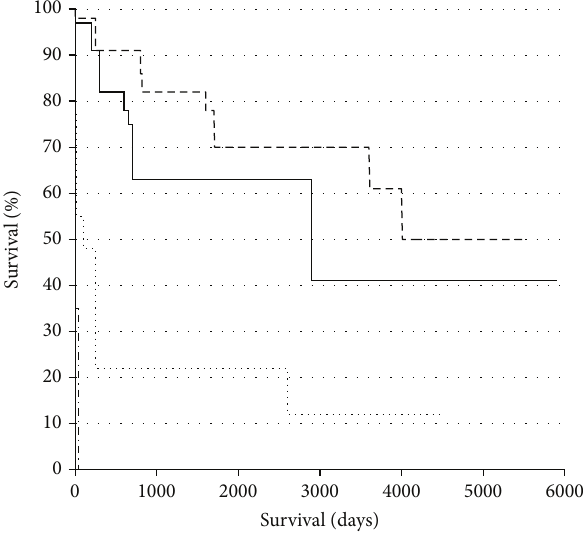
Figure 1: Km survival curves were plotted for patients grouped according to comorbidity score (dashed line: comorbidity 0 + 1; continuous line: comorbidity 2 + 3; dotted line: comorbidity 4 + 5; and dashed/dotted line: comorbidity > 6). Logrank test for trend indicated a significant increase in rate of death with comorbidity score, and compared with comorbidity 0 + 1, the hazard ratios for death were found to increase with comorbidity score, 1.94